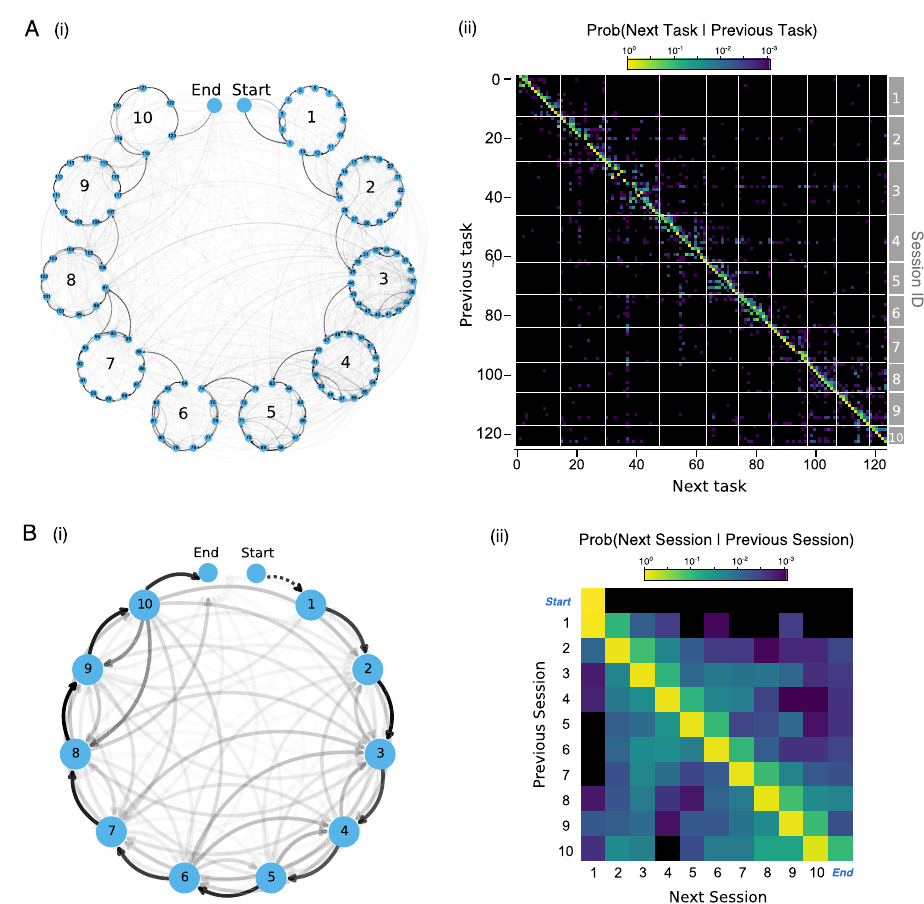
Figure 5. ( A (i)) The transition probability between tasks π is represented as a transition graph. Each blue node corresponds to a task, each sub-circle corresponds to a weekly session of tasks (numbered from 1-10), and the entire circle corresponds to the full course. The edge thickness between tasks corresponds to the probability π ij of transitioning to task j given the previously acquired task i . Generally, there is a high probability of transitioning between sequential tasks; however, there are often large non-sequential transition probabilities. ( A (ii)) A heatmap of the matrix π (in logarithmic scale). Off-diagonal elements correspond to deviations from the course structure. ( B (i)) A transition probability graph between weekly sessions, where each node corresponds to a session and the edges between sessions i and j are weighted by the probability of transitioning between any task in session i to any task in session j . Although there is a strong probability of sequentially completing the sessions, there are is a significant number of deviations from the session sequence (e.g., from session 10 to sessions 9 and 8, or from session 6 to session 3). The transitions within a session (self-loops) and the transition from start to session 1 are not shown for clarity of visualisation ( B (ii)) A heatmap of the transition probability between sessions. The diagonal exhibits the highest probability given that a learner is most likely to transition between tasks within a session followed by the upper diagonal, representing transitions to the next session in the nominal